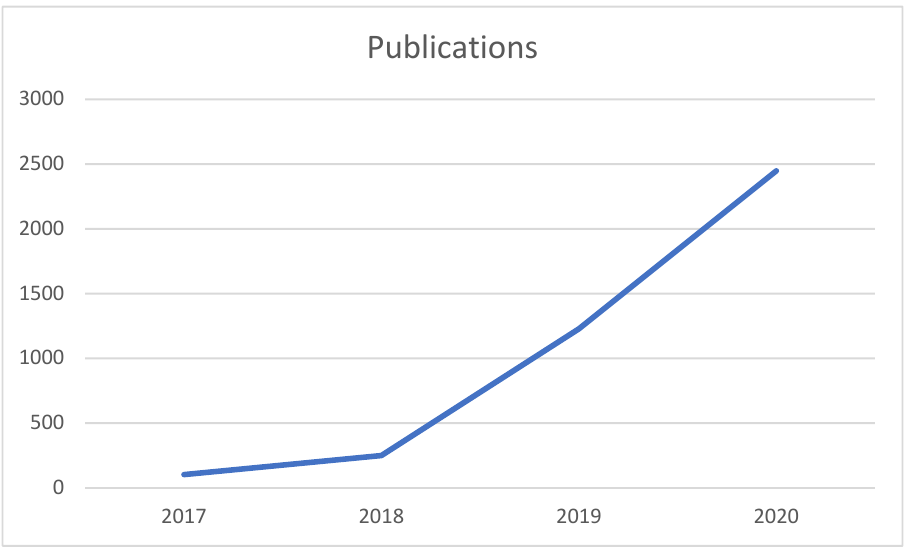
Figure 1. Publications from 2017 to 2020 in Animals.